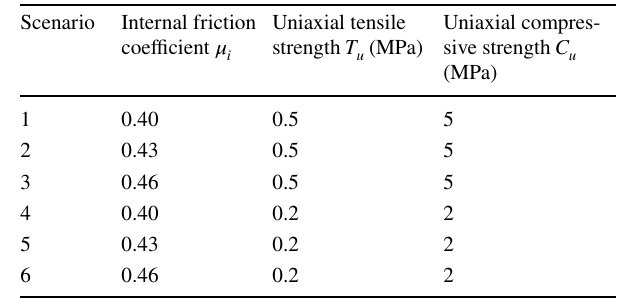
Table 3 Parameters used for the simulation of six landslide process scenarios considering the effects of rainfall and weathering